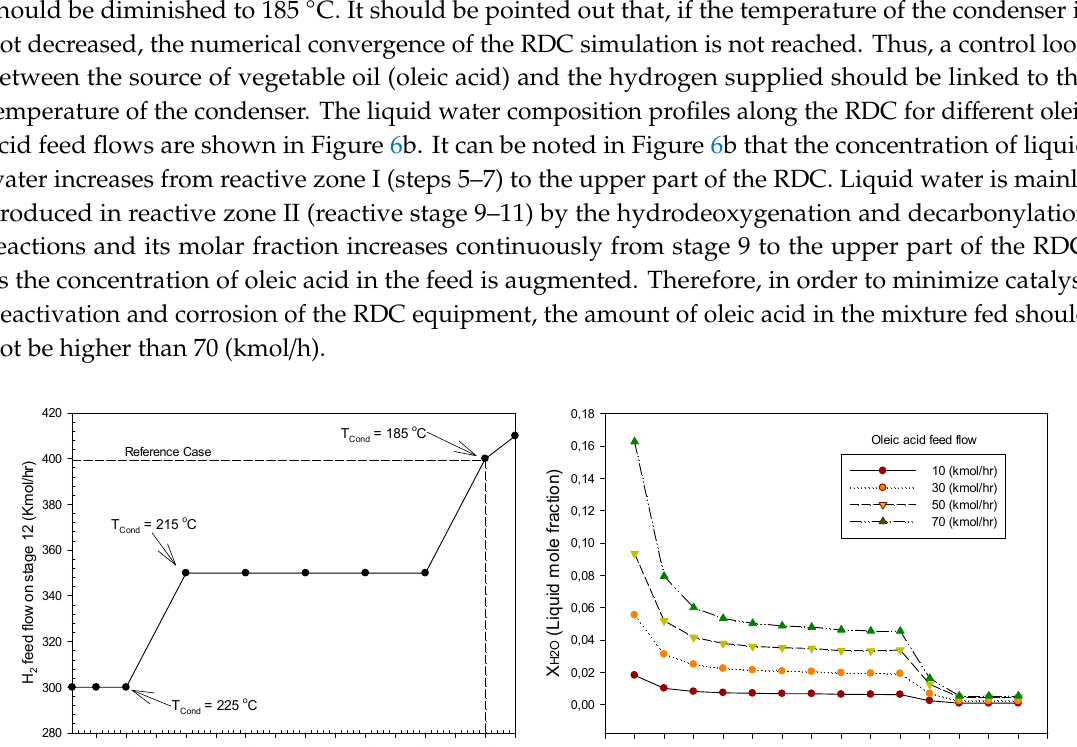
( b ) Figure 7. ( a ) RDC profiles for oleic acid-petro-diesel blend fed at stage 9 at 30 atm. ( b ) Gas compositions profile along the RDC. Reproduced with permission from García-Sánchez et al., Proceedings of the 28th European Symposium on Computer Aided Process Engineering; Published by Elsevier B.V., 2018. [20].